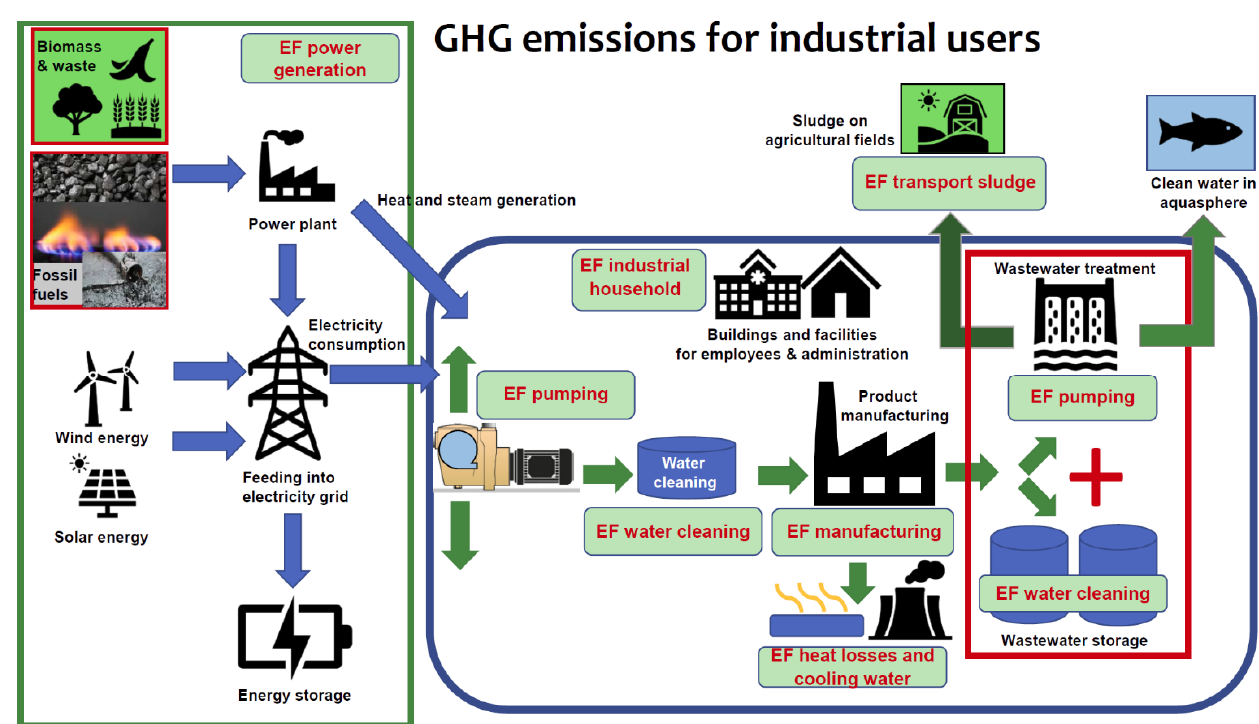
Figure 2. Greenhouse gas (GHG) emission sources in the water sector.